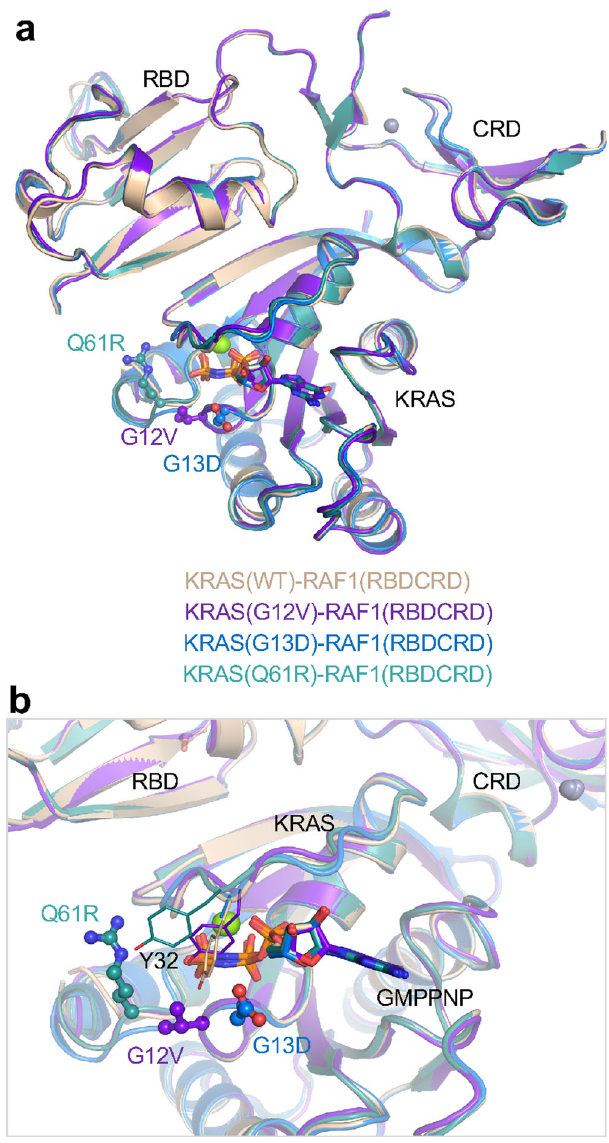
Fig. 6 Structural comparison of WT KRAS-RBDCRD with the oncogenic mutants G12V, G13D, and Q61R of KRAS bound to RBDCRD. a Structural superposition of WT, G12V, G13D, and Q61R mutants of KRAS complexed with RBDCRD. The structural superposition was carried out using KRAS residues. Crystal form II of WT KRAS-RBDCRD is used here since it has the same space group as the oncogenic mutants. Oncogenic mutants and GMPPNP are shown in ball-and-stick and stick representations, respectively. The color scheme for different structures is shown in the panel. b Enlarged view showing oncogenic mutants, residue Y32 in the switch-I region, and KRAS-RBDCRD interface to highlight similarities and differences among structures of WT and oncogenic mutants of KRAS in complex with RBDCRD.